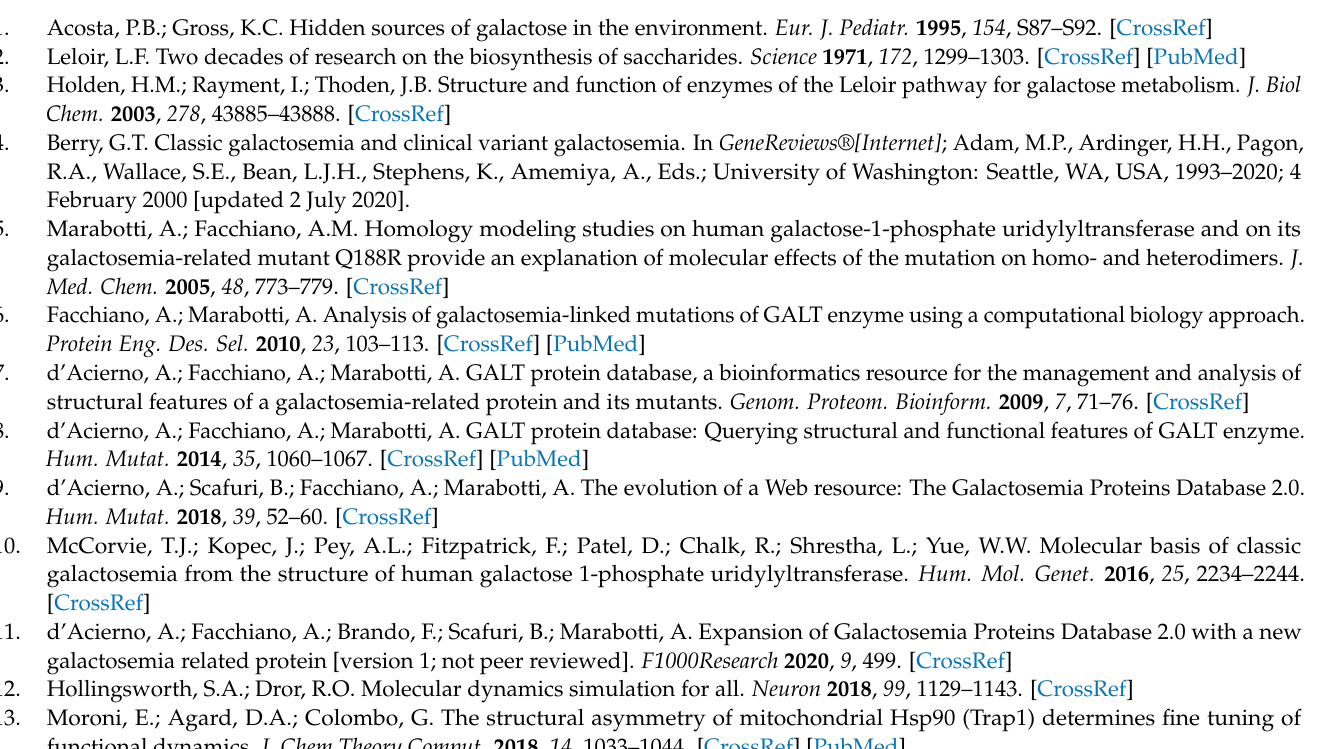
Supplementary Materials: Figure S1: DSSP analysis, Figure S2: Radius of gyration, Figure S3: SASA, Figure S4: Pair distance between enzyme and substrates, File S1: Quality check for wtGALT at 310